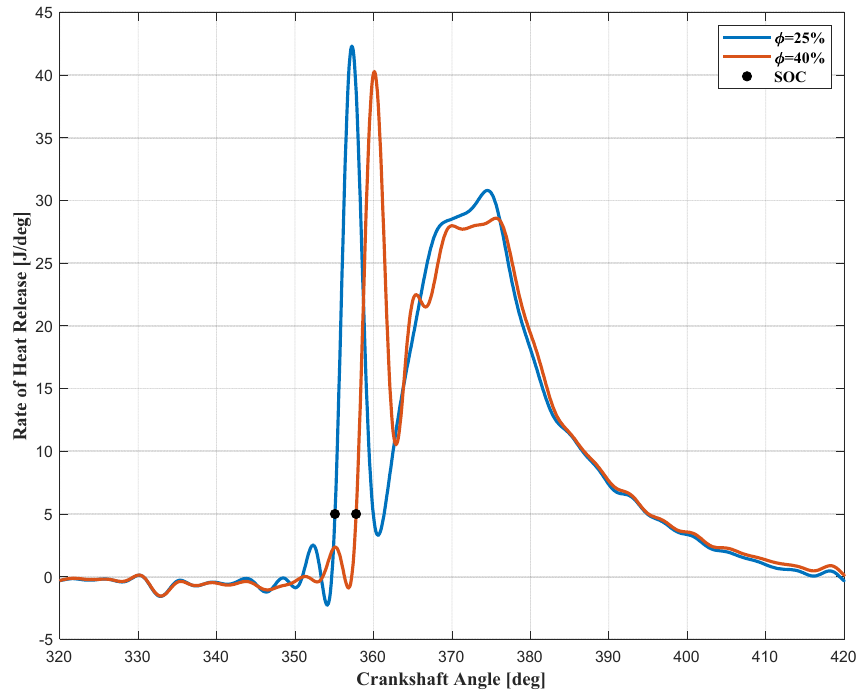
Figure 12. RoHR curves at different relative humidities.